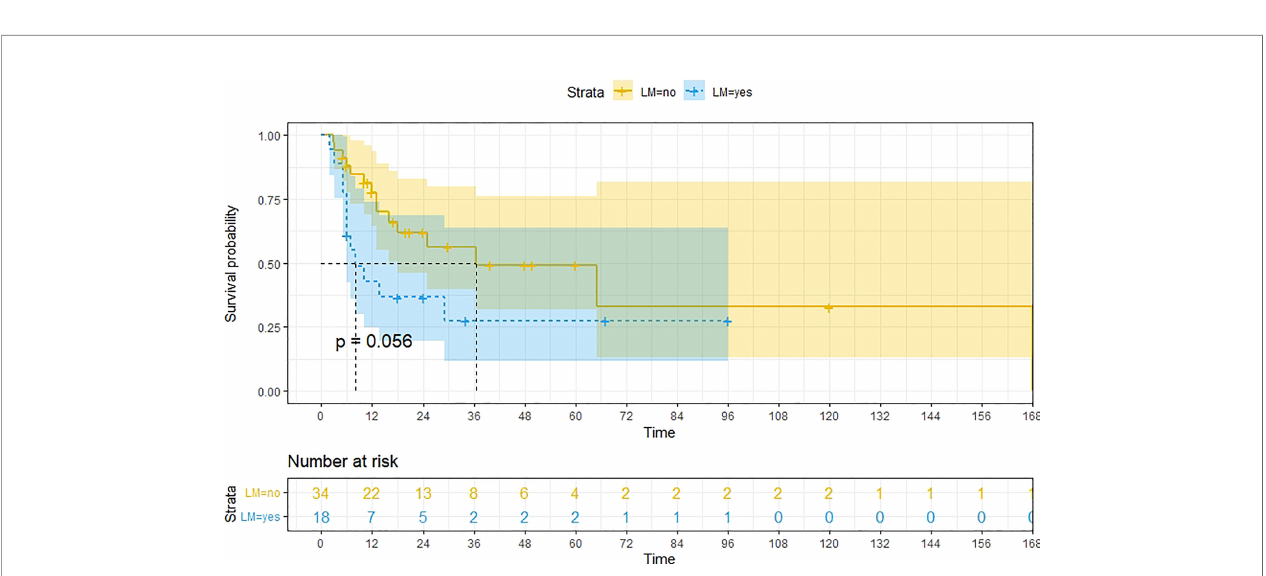
FIGURE 5 | Kaplan-Meier survival curves for OS in patients of no lymphatic metastases and Lymphatic metastases. The median OS for them are 37m, 8m